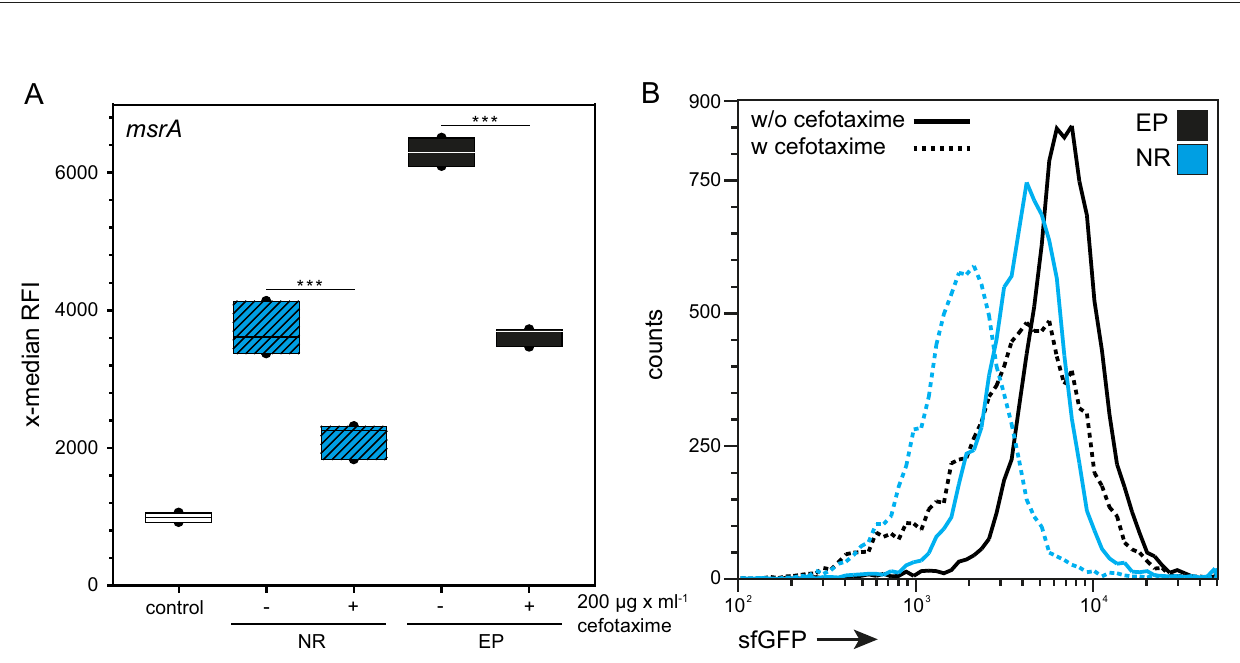
Fig. 5 Cefotaxime-treated non-replicating STM WT show slight induction of stress response. STM WT harboring AHT-inducible (NR) or constitutive (EP) dual- fl uorescence reporter for msrA was grown o/n in LB medium, in the presence of AHT or the NR reporter. Before infection, AHT was removed. RAW264.7 macrophages were infected, cefotaxime was added to the cells at 10 h p.i. if indicated, and cells were lysed at 24 h p.i. Liberated STM were recovered, fi xed and subjected to FC. As negative control, a dual FP reporter plasmid with sfgfp inactivated by a frameshift was used. The x-median ( A ) represents the P msrA -induced sfGFP signal of the DsRed-positive intracellular bacterial population, and B shows a representative histogram. Means and standard deviations of one representative experiment are shown. Statistical analysis was performed as described for Fig.